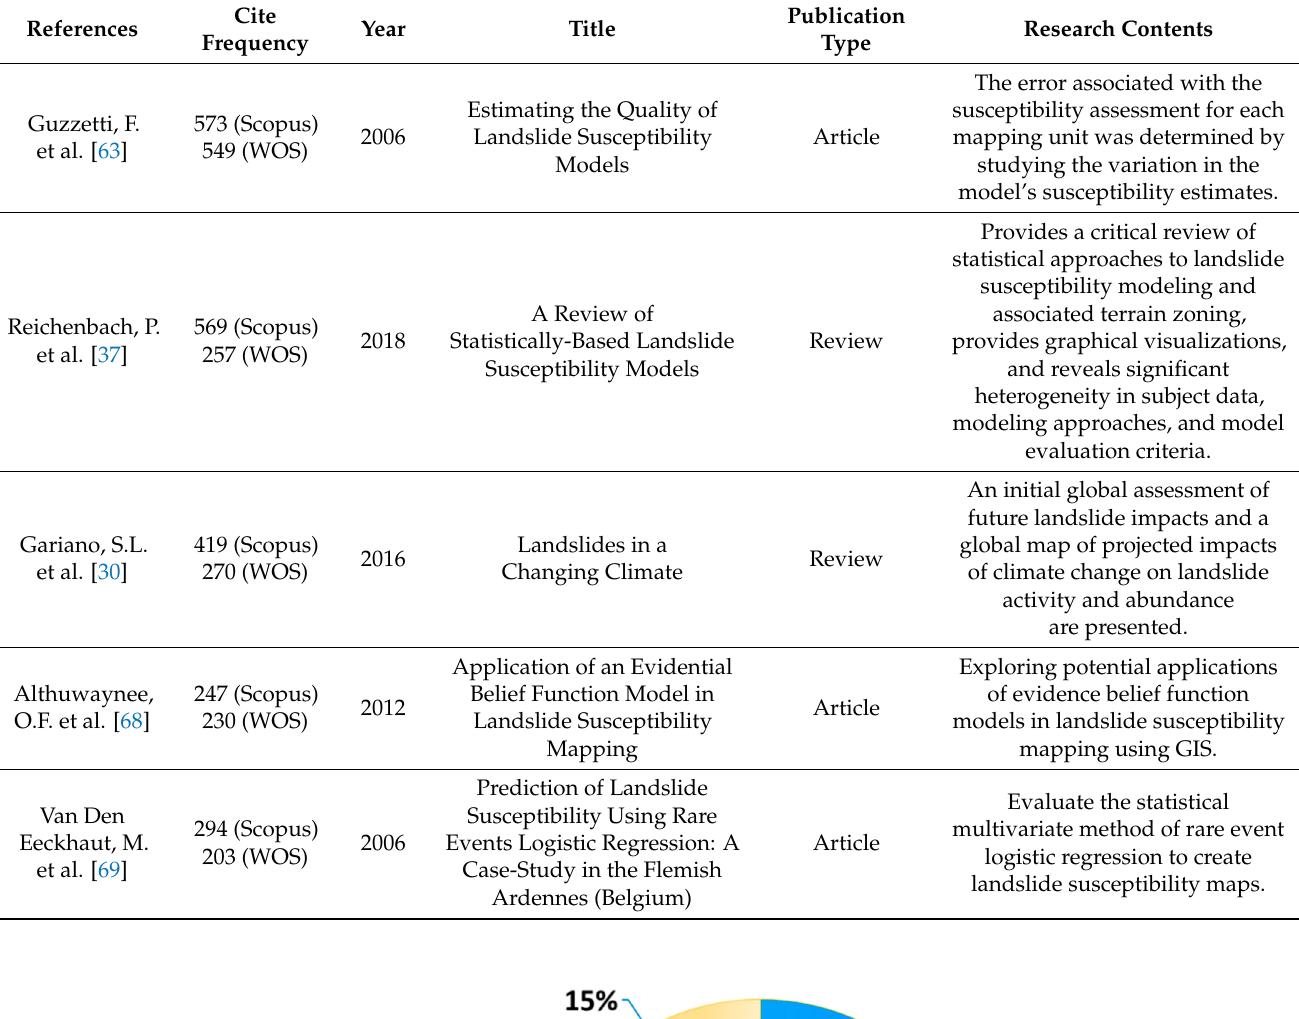
Table 3. Highly cited literature information table.